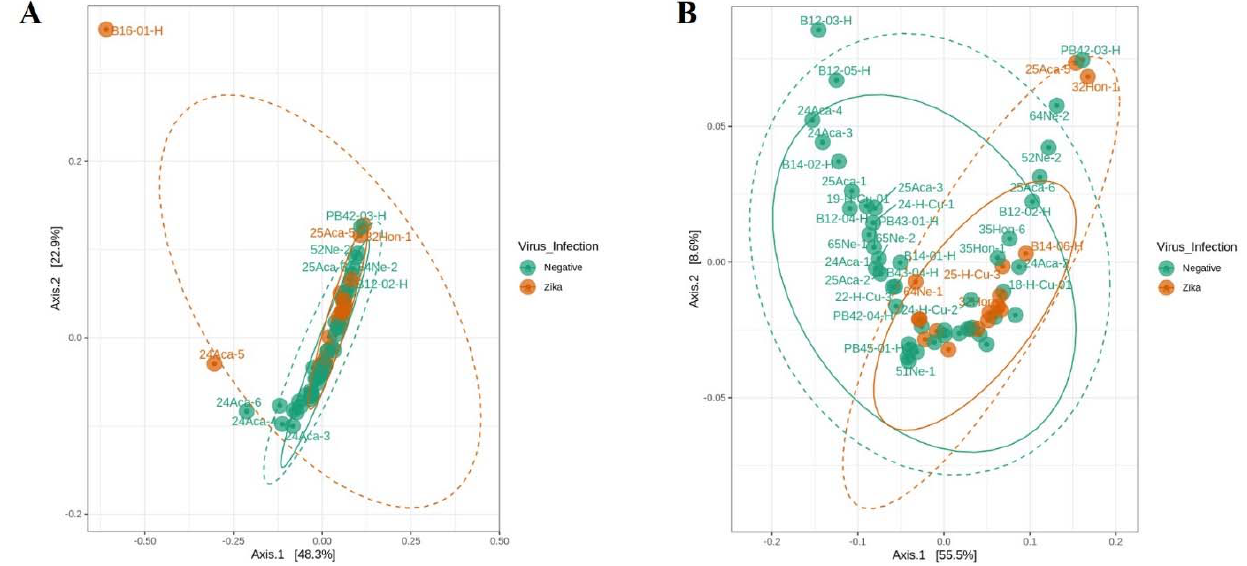
Figure 3. Outlier sample detection by PCoA analysis (Jaccard distance matrix). The analysis was made with a 95% confidence interval ellipse inferred using multivariate t-distribution. Three samples (B16-01-H, 24Aca-5, and 24Aca-6) were outliers and removed from the final analyses. ( A ) Before filtering. ( B ) After filtering.